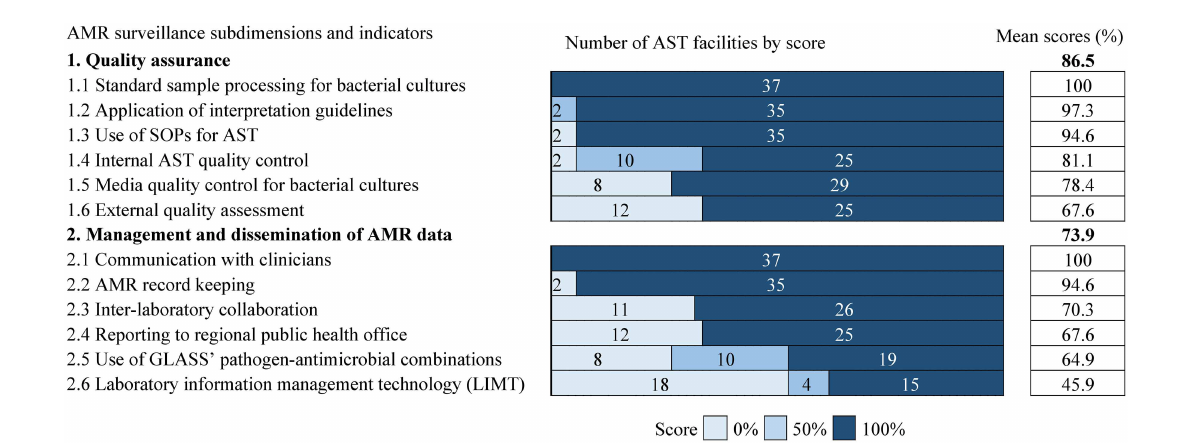
FIGURE3 The figure provides information on the distribution of performance scores for AMR surveillance practices across facilities. The list of subdimensions and their component indicators is on the left. Shading and integers represent scores and facility count, respectively. The scores are ordered from left to right by increasing shade intensity. The number of facilities corresponds to column width. Percentage values on the right are the average score of all cells in each row. Average scores are ranked in descending order by subdimension and component indicator. AST, Antimicrobial Susceptibility Testing; SOPs, Standard operating